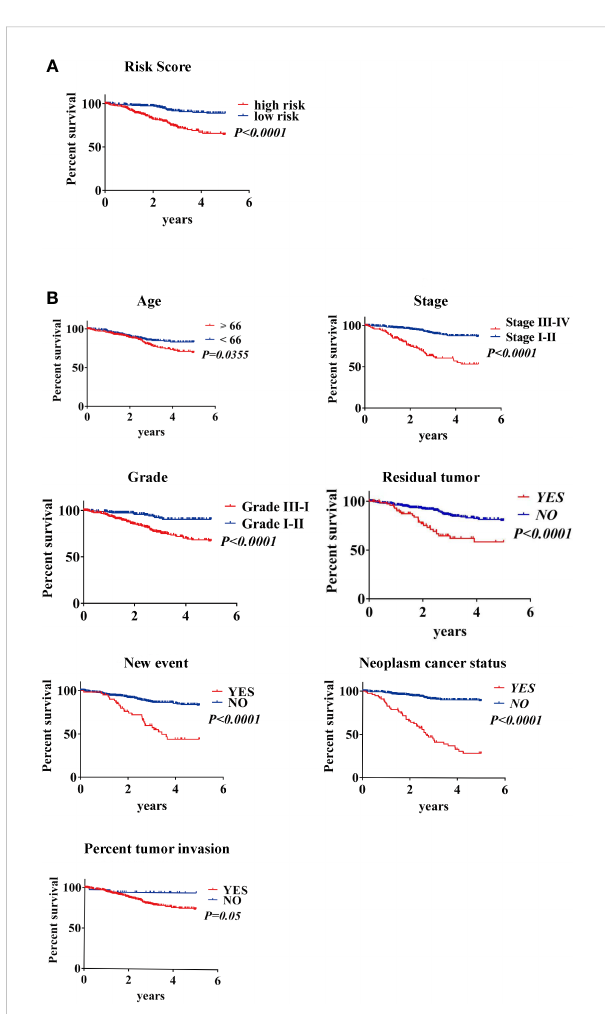
FIGURE 6 Kaplan – Meier survival analysis of EC patients in the TCGA data set (A) K – M survival curve of high/low-risk EC patients (B) Clinical features, including age, stage, grade, residual tumor, new event, neoplasm cancer status, and percent tumor invasion, predict patient survival.